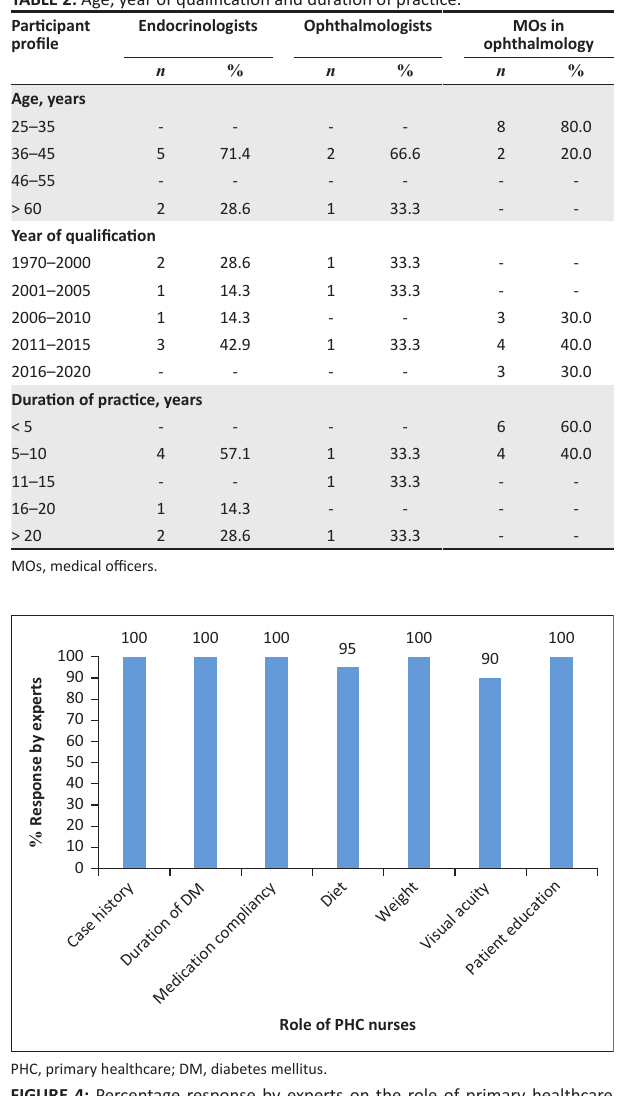
FIGURE 4: Percentage response by experts on the role of primary healthcare nurses in the management of patients with diabetes mellitus.